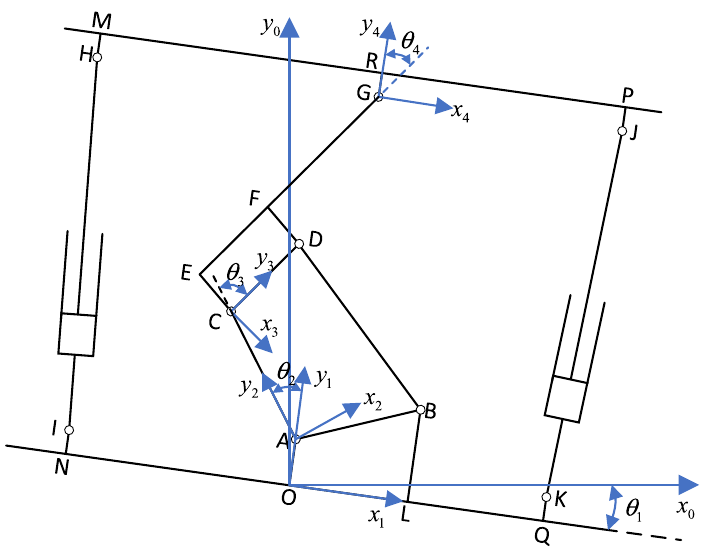
Figure 8. Advanced hydraulic support of the D–H matrix coordinate